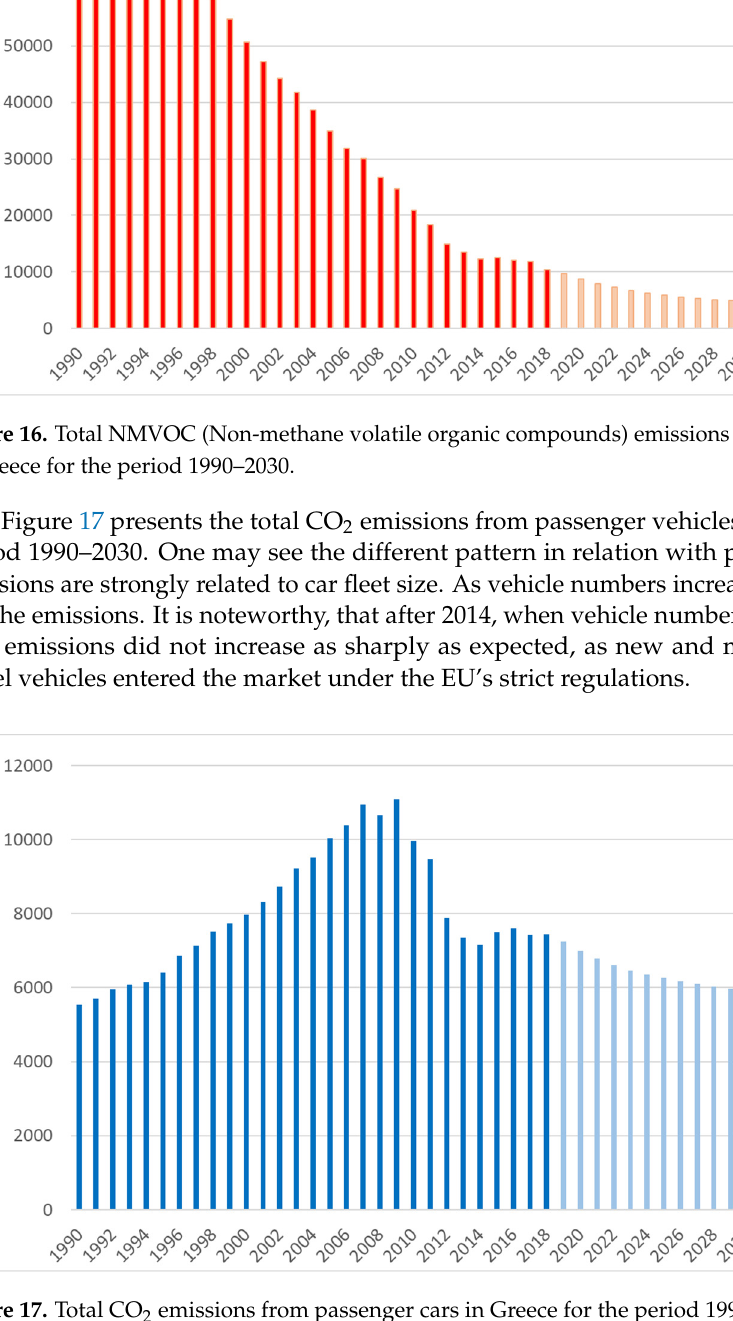
Figure 17. Total CO 2 emissions from passenger cars in Greece for the period 1990–2030.